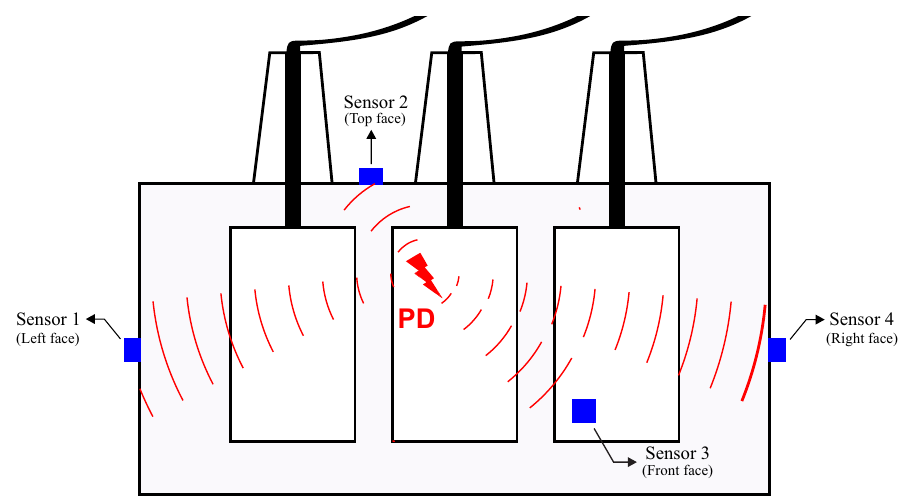
Figure 1. Positions of the ultra-high frequency (UHF) sensors.